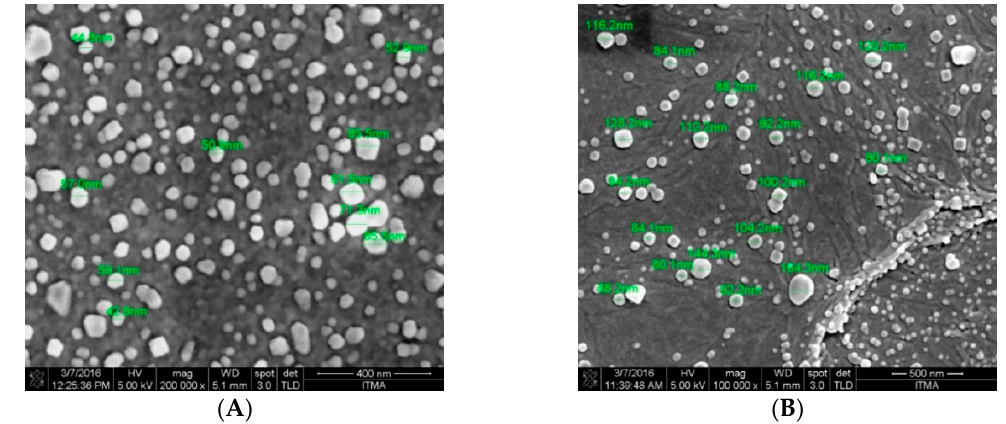
Figure 6. Images of FESEM morphological analysis of ( A ) CNP° and ( B ) CNP°-CGA. Particles appeared as irregular, dispersed spherical-shape for all parameters.